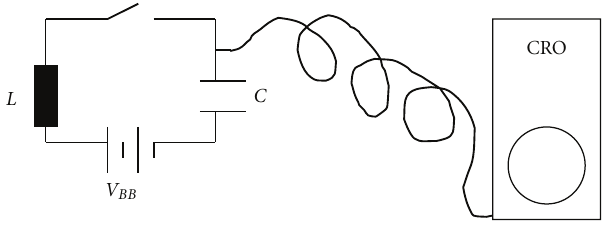
Figure 6: The oscillator circuit (a second-order di ff erential equa- tion), with semi-infinite cable CRO-probe acting as half order